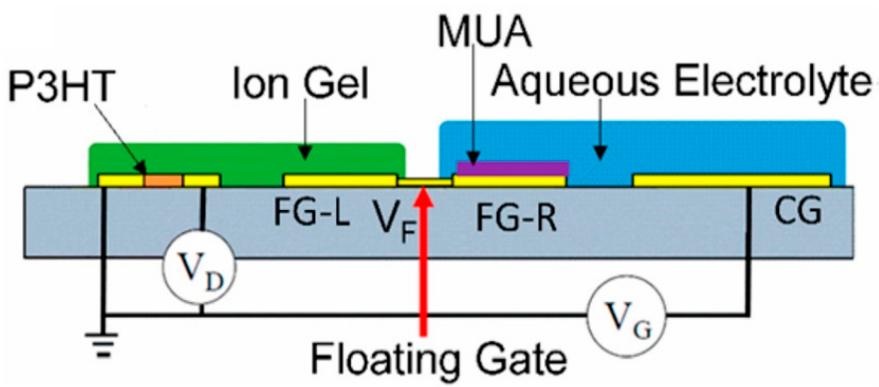
Figure 11. Representative diagram of the floating gate transistor. Reprinted with permission from [159]. Copyright 2018, American Chemical Society.